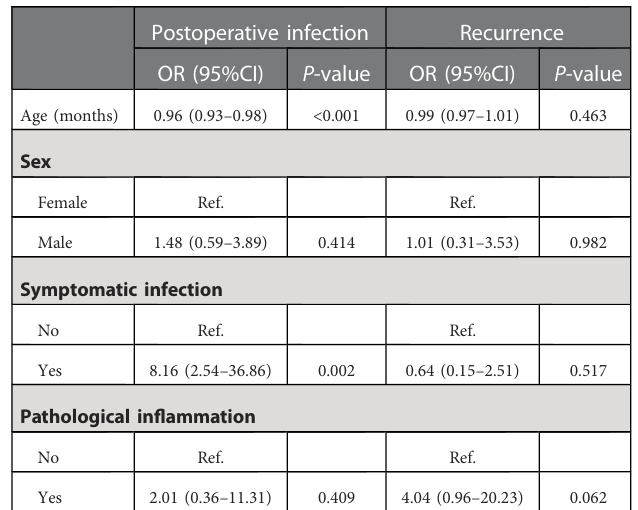
TABLE 3 Multivariable logistic regression estimates of postoperative infection by age, sex, symptomatic infection, and pathological in fl